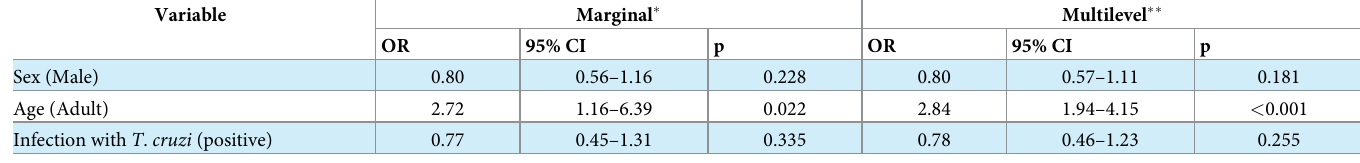
Table 2. Marginal and multilevel logistic regression that describes associations between S . stercoralis infection and age, sex, and infection with T . cruzi . Variable